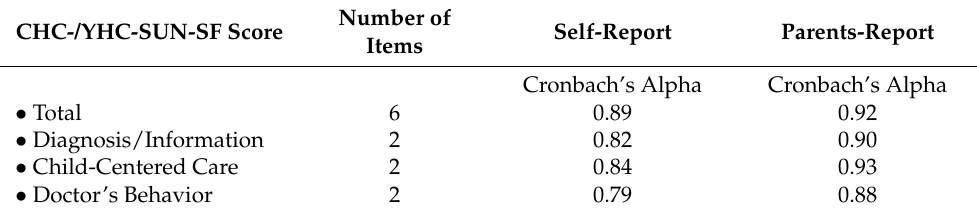
Table 3. Internal consistencies for the overall scale and subscales of the self-report and parents report versions of the CHC-/YHC-SUN-SF ( n = 469).